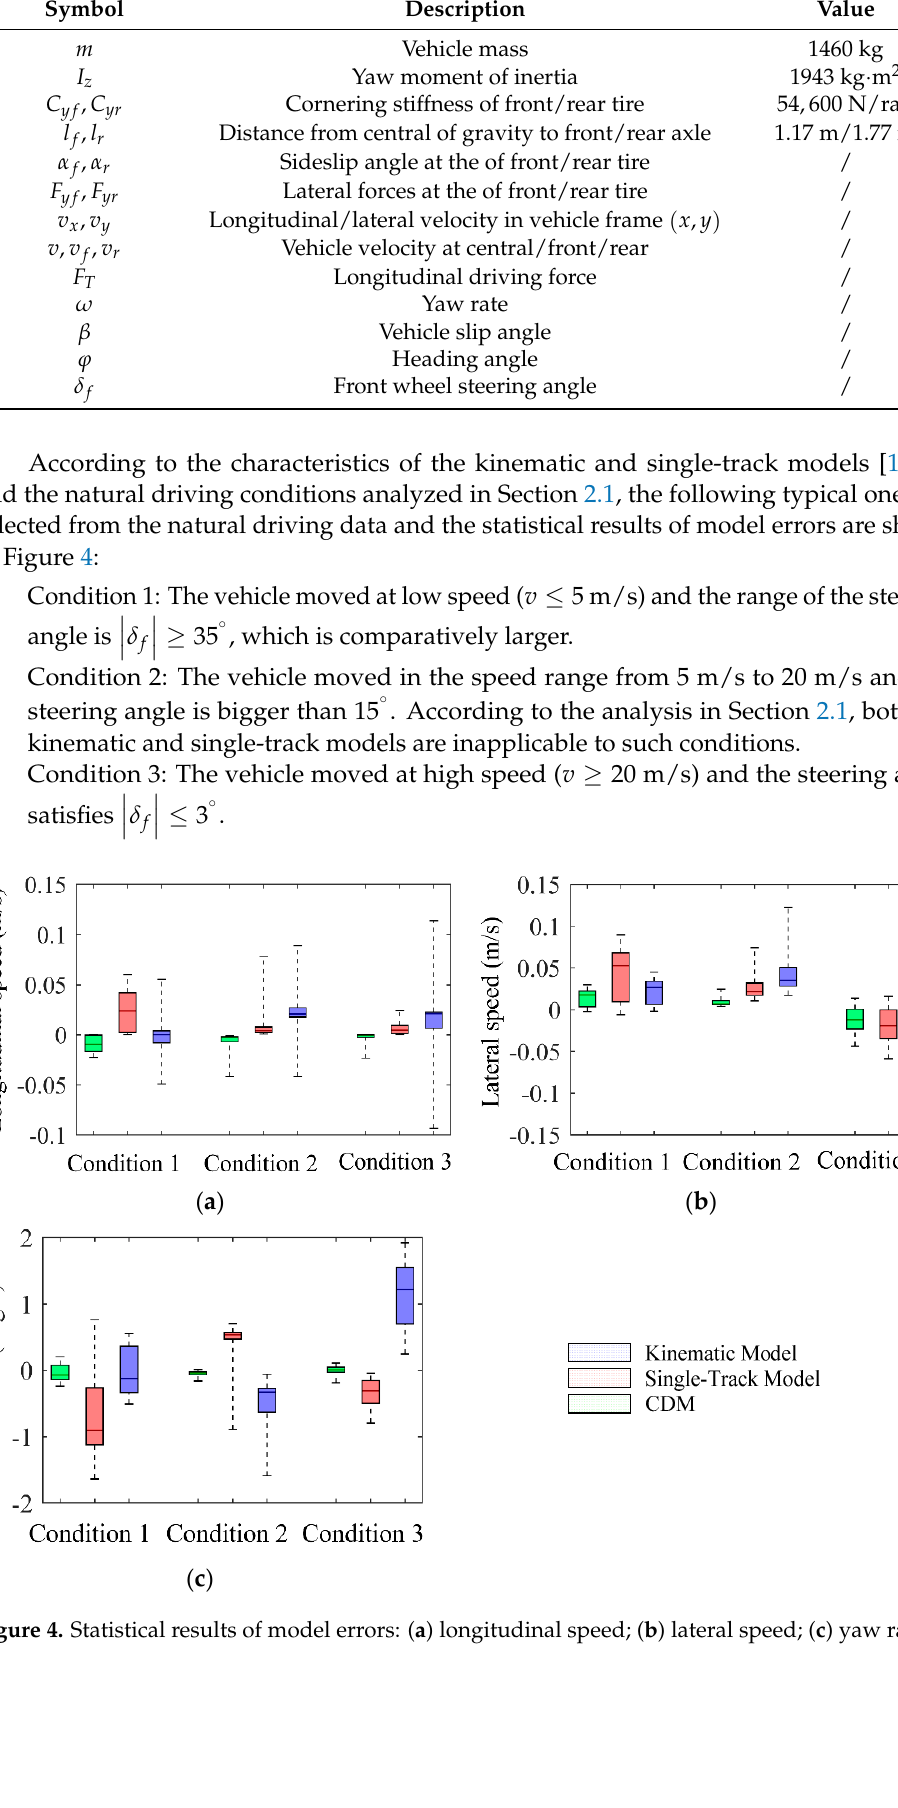
( b ) Figure 5 . Simulation inputs: ( a ) longitudinal driving force 𝐹 (cid:3021) ; ( b ) front wheel steering angle 𝛿 (cid:3033) .